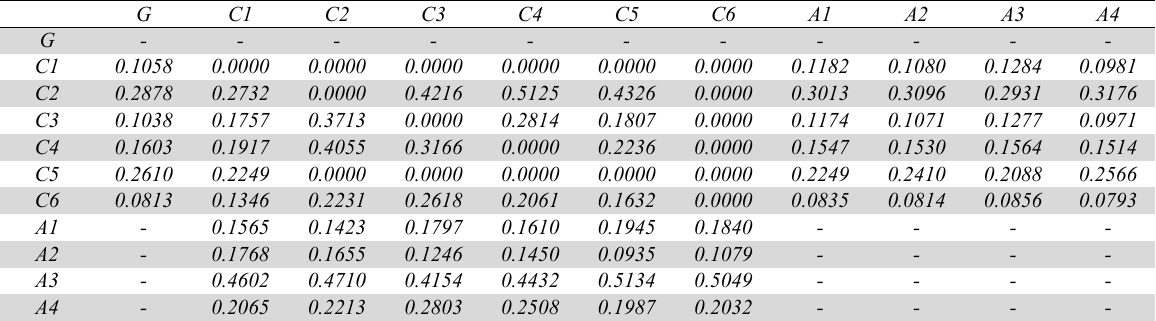
Unweighted Super-matrix